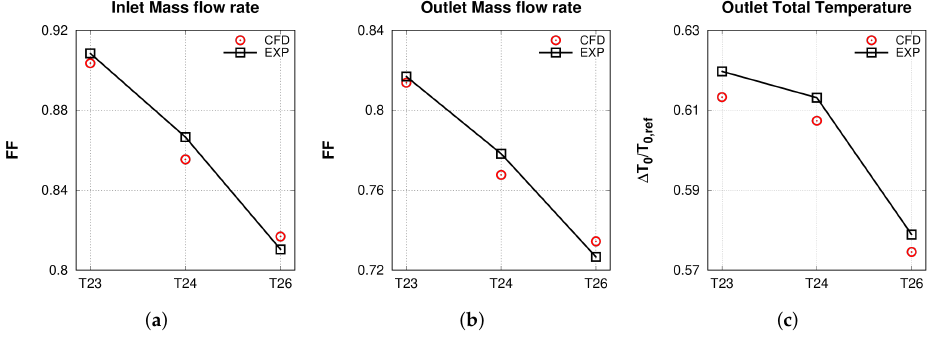
Figure 3. Compressor inlet ( a ) and outlet ( b ) mass flow rate, and outlet total temperature ( c ).